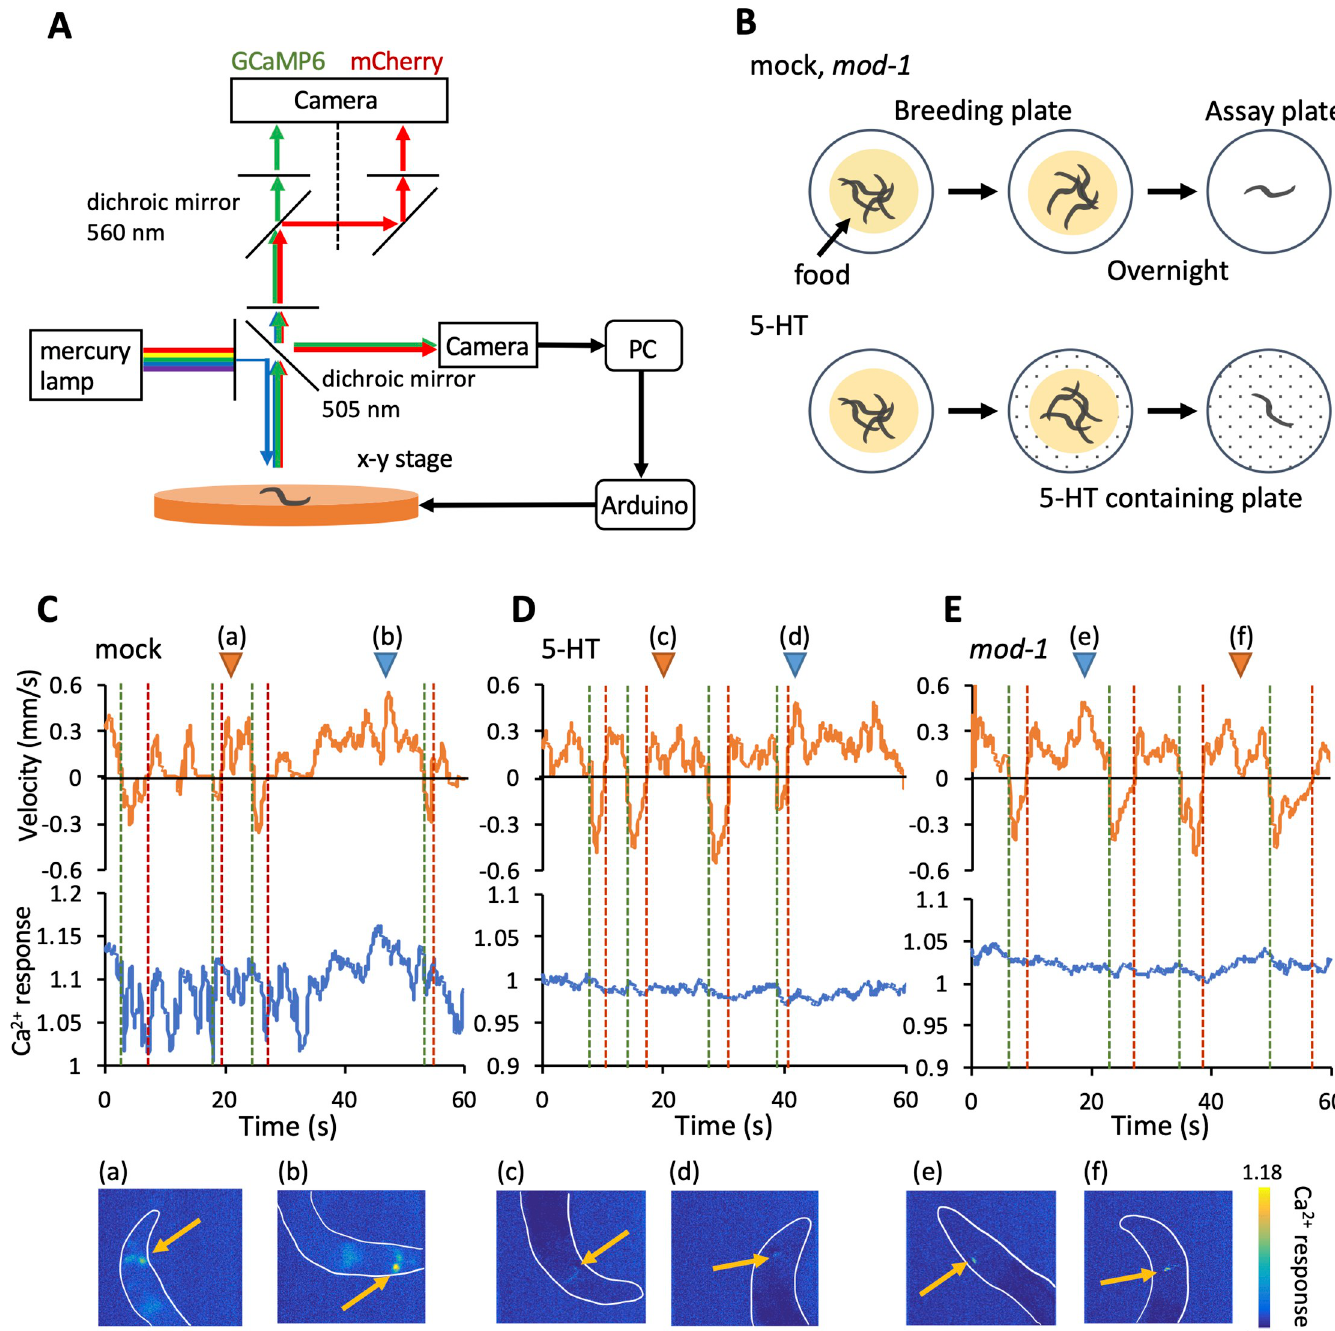
Fig 1. 5-HT modulates the neural activity of the RID. (A) Tracking and imaging system. The neural activity of the RID and the behavior of worms were simultaneously recorded using the custom-made tracking and imaging system (see Materials and methods). (B) The preparation of three groups: mock (n = 9), serotonin (5-HT) pre-exposed (n = 8), and mod-1 mutation (n = 9). Worms expressing the Ca 2+ sensor in the RID were cultured on other breeding plates the day before the experiment. During the experiment, the worm was placed on the assay plate. For the 5-HT pre-exposed group, the breeding plates and assay plates contained 4 mM 5-HT. (C–E) Representative examples of velocity and RID neural activity in mock (C), 5-HT exposed (D), and mod-1 mutant animals (E). The vertical dotted lines represent the timing when the worm changed its locomotive direction from backward to forward (red) and from forward to backward (green). The images are representative ones when the velocity was low (a, c, f) and high (b, d, e).